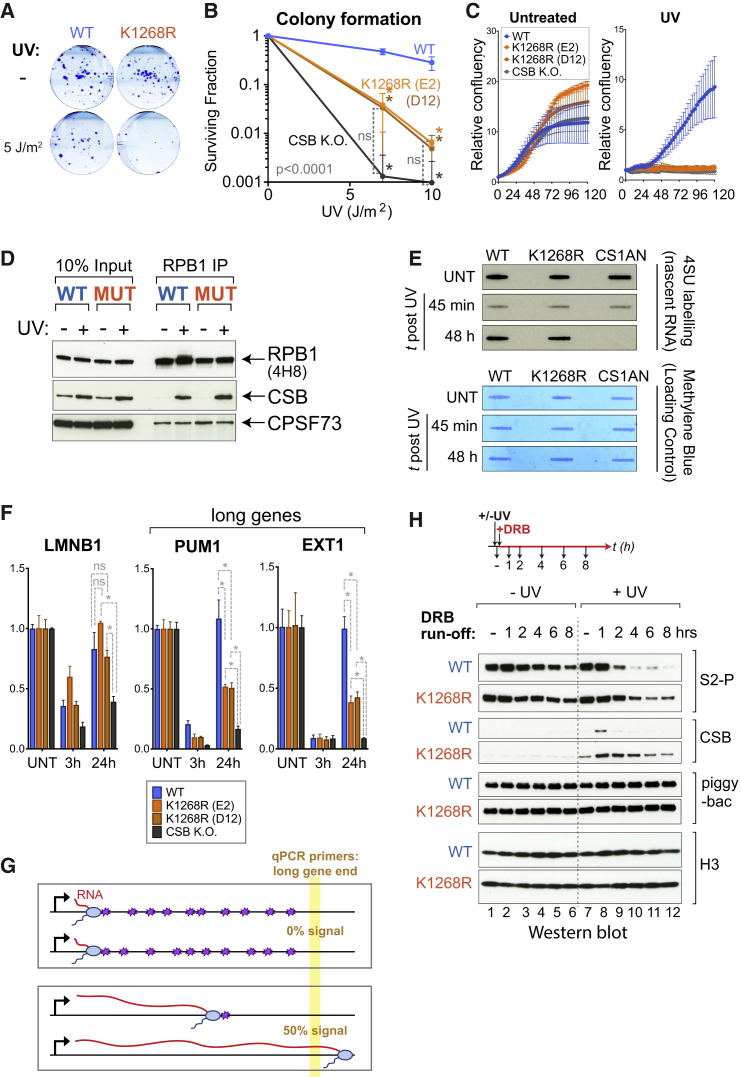
K1268 Ubiquitylation Is Required for Cell Survival upon DNA Damage and Affects Repair Kinetics(A) Representative images of colony formation assays before and after UV irradiation (5 J/m2) (switchover system).(B) Quantification of colony formation assays (n = 3) as in (A), but using K1268R CRISPR KI cells and CSB KO control cells. Data are presented on a log10 scale, as average surviving fractions ± SD. Asterisks indicate significance of differences (comparison versus WT cells) (p < 0.05, Tukey two-way ANOVA). ns, not significant (comparison versus CSB KO cells).(C) Growth assays before (left panel) and after UV irradiation (20 J/m2) (right panel). Cell confluency was monitored every 3 h using Incucyte and the data were normalized to t = 0 for each well. Data are represented at each 3 h time point as average relative confluency of 3 biological replicates ± SD.(D) Immunoprecipitation (IP) of RPB1 from chromatin, followed by western blot for RPB1, CSB and CPSF73 (control). Cells were UV-irradiated (20 J/m2, or not) and collected 45 min later for IP.(E) 4SU-slotblot showing global nascent RNA production before and after UV irradiation (10 J/m2). Cells were pulse-labeled with 4SU 15 min prior to collection. Methylene blue staining is the loading control.(F) RT-qPCR measuring nascent transcription before or after UV-irradiated (20 J/m2) at LMNB1 (60 kb), EXT1 (317 kb), and PUM1 (134 kb), using primers at their 3′ ends. Data are represented as mean ± SD, normalized to the mature GAPDH transcript, and to untreated conditions. Statistically significant differences (three biological replicates) are indicated with asterisks (p < 0.05, multiple t tests, Holm-Sidak correction).(G) Schematic illustrating the relationship between DNA damage burden (purple stars) and nascent transcription on a long gene. Restart is only detected when all lesions have been removed; 50% restart indicates that all lesions have been removed from 50% of genes in the cell population.(H) Experimental approach (top) and western blot analysis (bottom), with DRB added immediately after UV irradiation, and samples collected at the indicated time points. The abundance of S2-phosphorylated (S2P, 3E10) RPB1, as well as CSB and histone H3 (control) in chromatin is shown. Piggybac, product of transposon insertion into the CSB locus, was used as loading/specificity control.See also Figure S2.